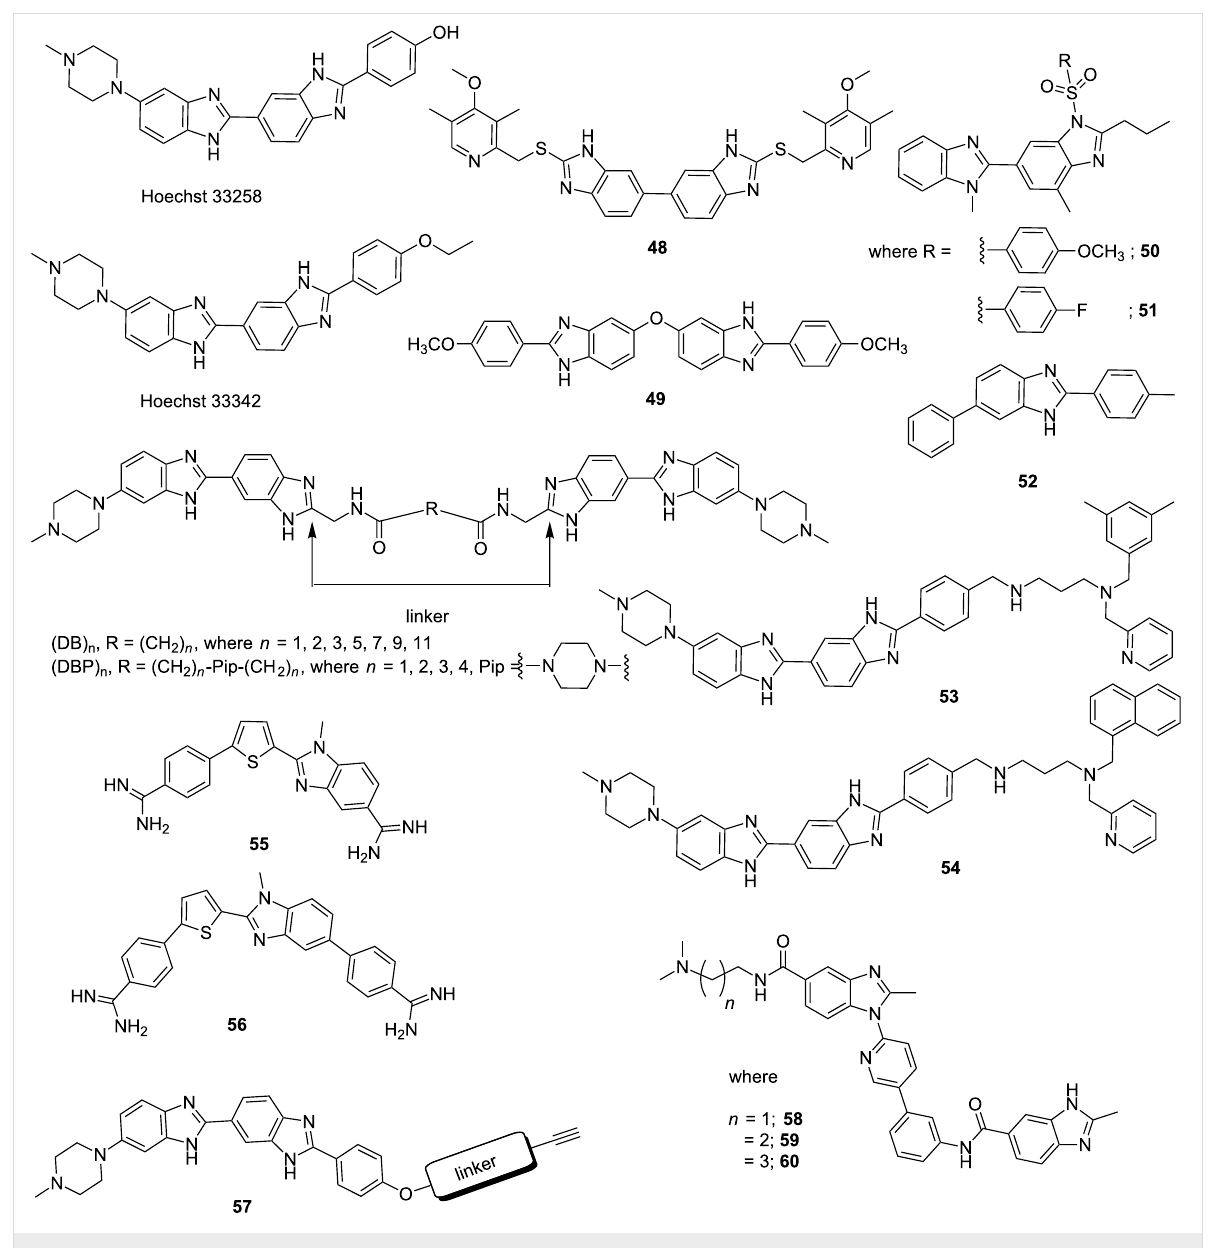
Figure 10: Chemical structures of bisbenzamidazoles Hoechst 33258 and 33342 and their synthetic structural analogs by varying substitutions and